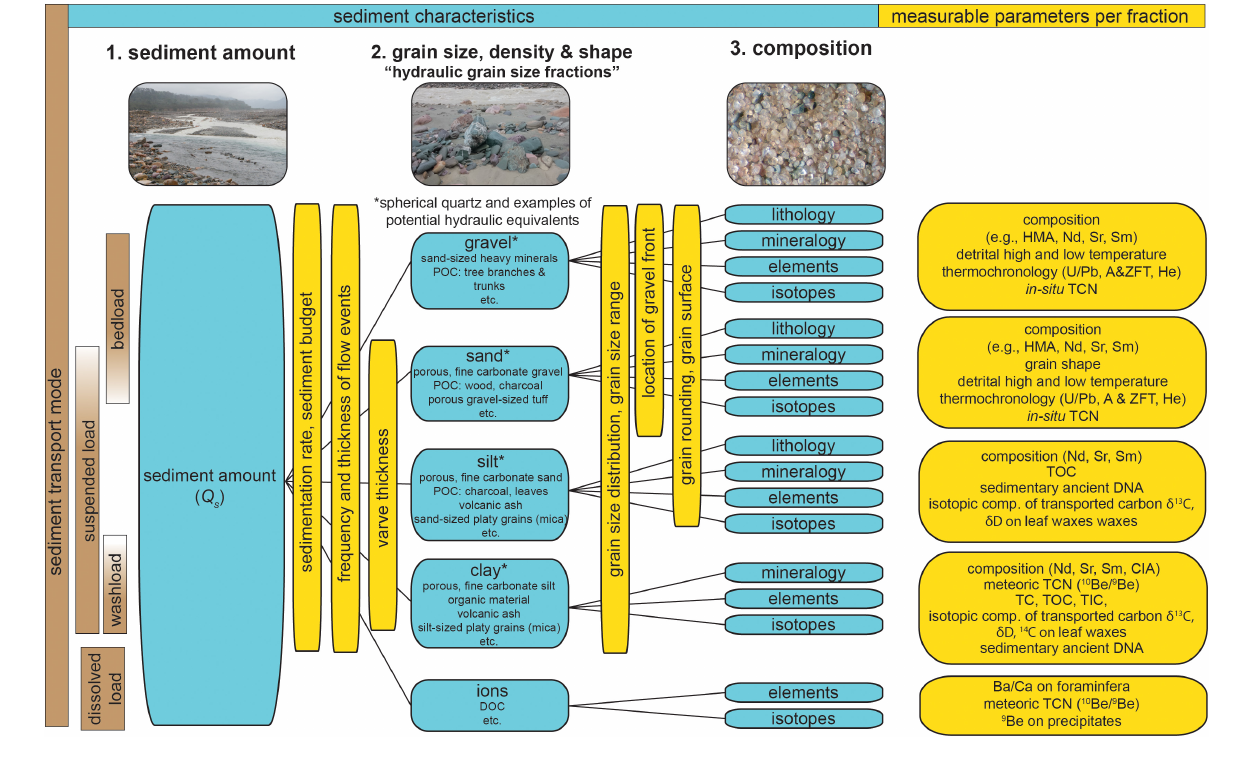
FIGURE 2 | Subdivision of signals based on sediment characteristics. Information on boundary conditions can either be stored in the amount of sediment (or anthropogenic particles) transported per time, the grain size and shape distribution of that sediment and its changes through time, or within the changing sediment composition (blue boxes). Examples of parameters measured for environmental reconstructions (yellow boxes) can relate to any of those sediment characteristics. Individual fractions of a sediment package can differ in their primary transport mode (brown boxes) and, hence, in times required to transport the sediment to the sink. Therefore, we suggest to subdivide signals based on hydraulic grain size fraction . A hydraulic grain size fraction is defined by the size range of spherical quartz grains, but includes other grains that are transported jointly due to similar hydraulic behavior. The presented list of regularly measured sedimentary parameters (yellow boxes) is not exhaustive. TC, total carbon; TOC, total organic carbon; TIC, total inorganic carbon; POC, particulate organic carbon; DOC, dissolved organic carbon; TCN, terrestrial cosmogenic nuclides; HMA, heavy mineral analysis; A&ZFT, apatite and zircon fission track; CIA, chemical index of